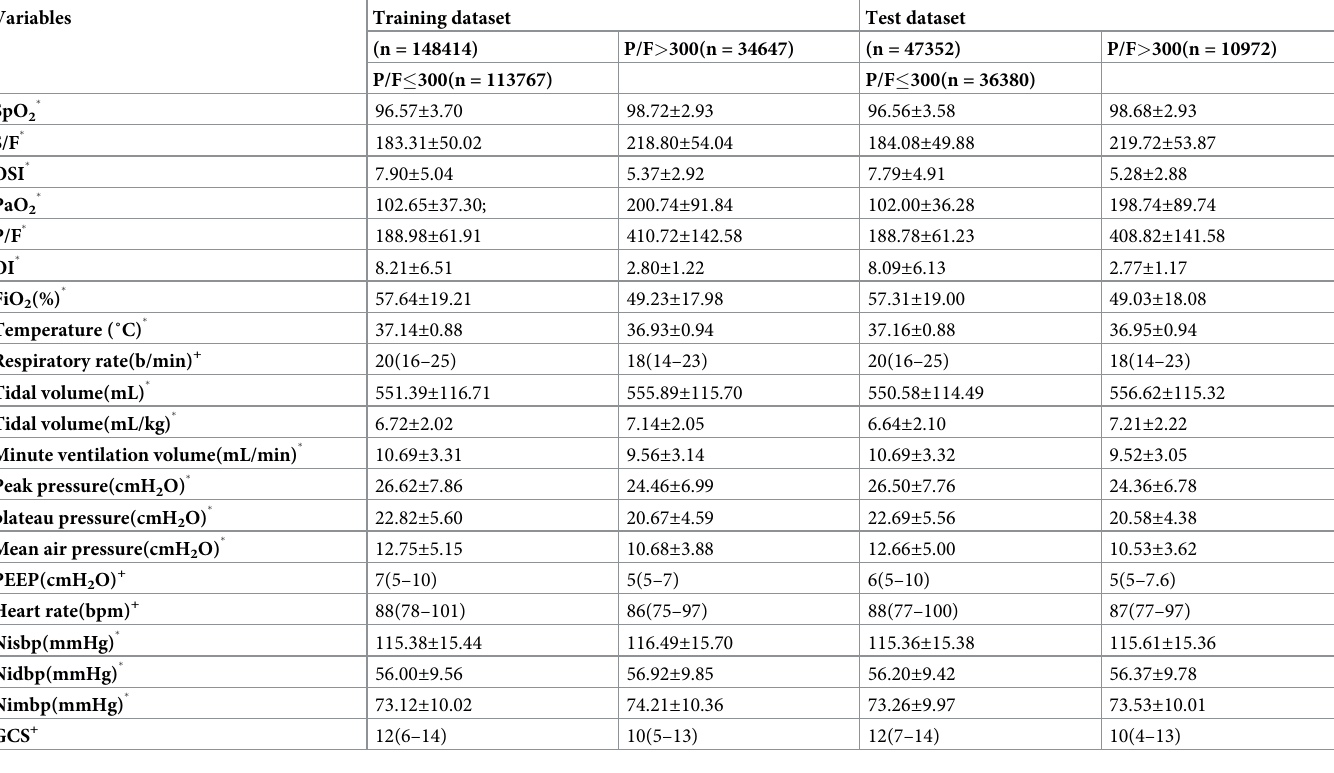
Table 3. Patient characteristics in training and test sets (Nisbp: Noninvasive systolic blood pressure, Nidbp: Noninvasive diastolic blood pressure, Nimbp: Noninva- sive mean blood pressure, OI: ( FiO 2 × Mean air pressure )/ PaO 2 , OSI: ( FiO 2 × Mean air pressure )/ SpO 2 .